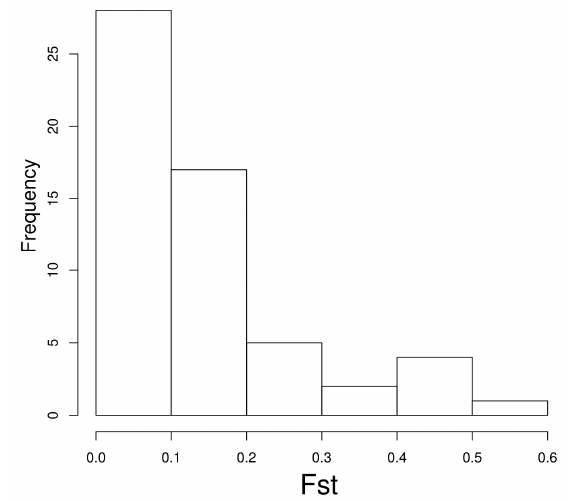
Figure 3. Fst values for polymorphic microRNA target sites experimentally evaluated with PASSPORT-seq (see main text).